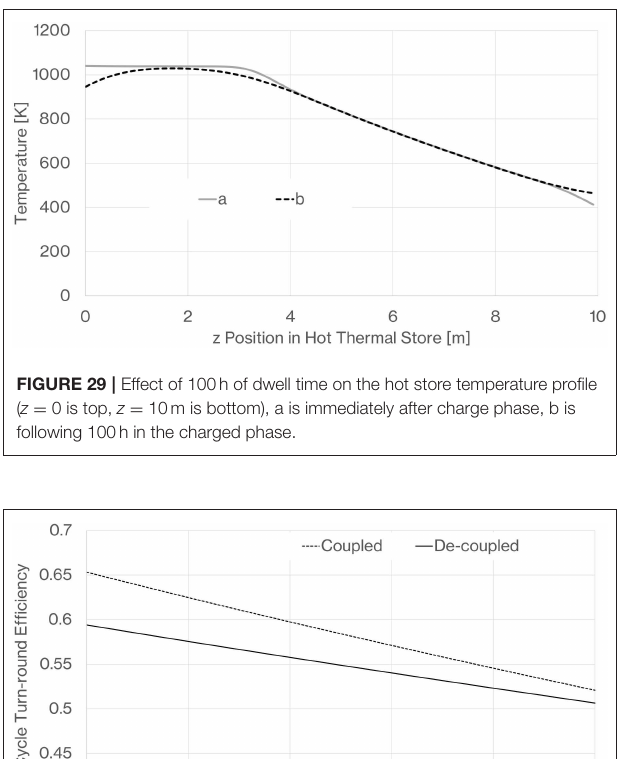
stores as compared to the multiple pressure vessels of the coupled system.